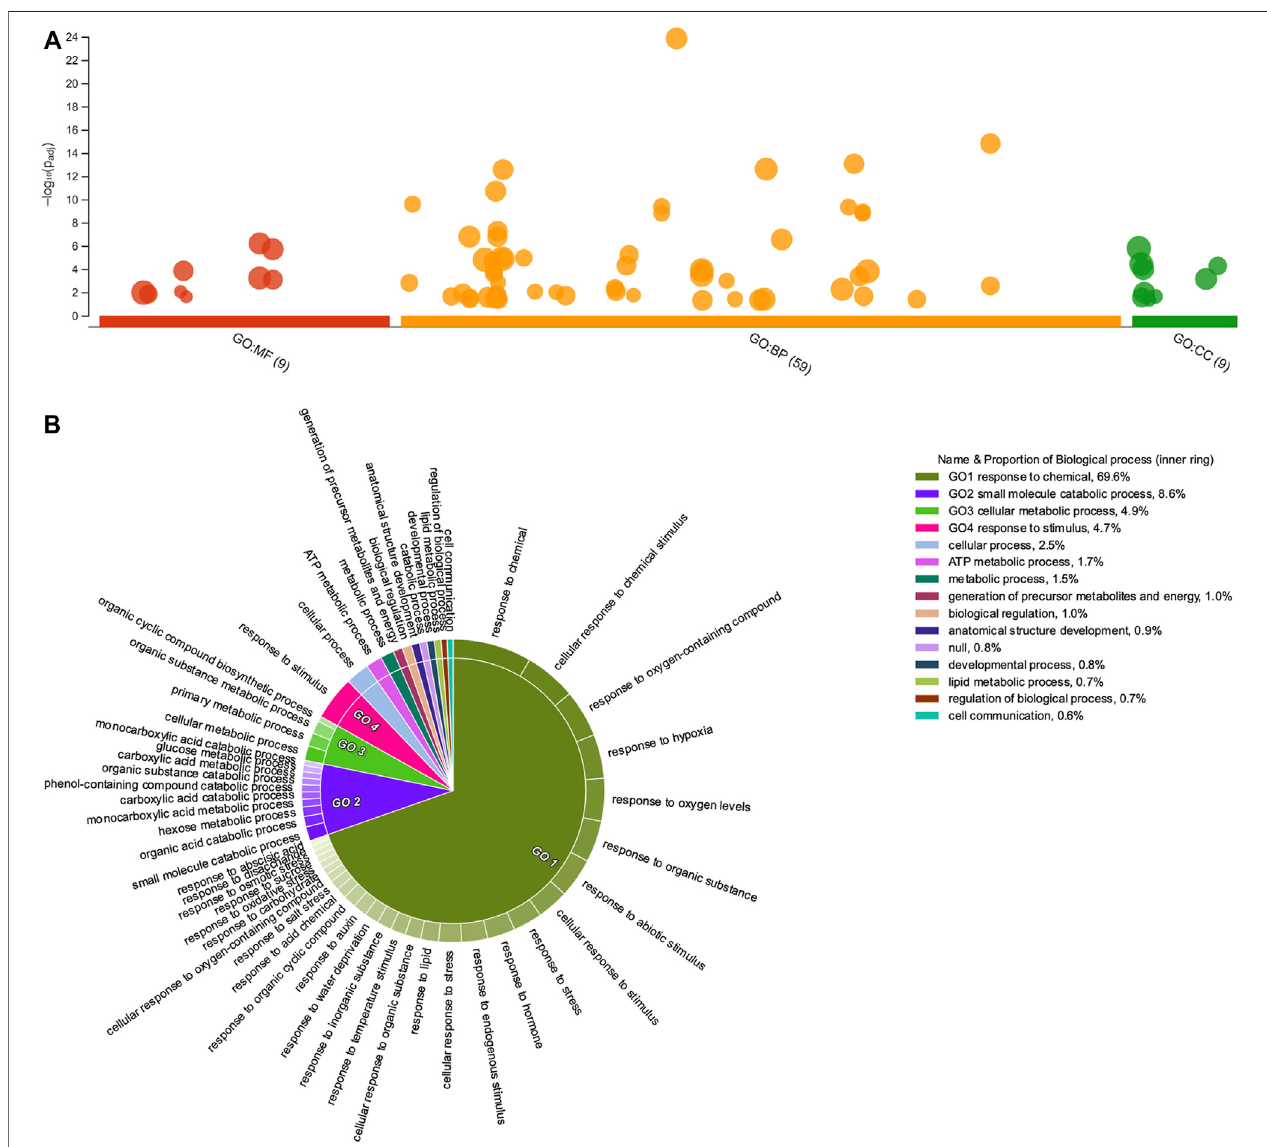
FIGURE 5 | Gene Ontology enrichment of downregulated Psittacanthus schiedeanus uniGenes involved in compound endosperm development after seed germination. (A) Manhattan plot illustrating the GO enrichment analysis results separated into the three major categories: MF (molecular functions), BP (biological processes), andCC (cellularcomponents).Thenumber inthesourcenameinthe x -axis labelsshowshow manyGOterms weresigni fi cantlyenriched (g:SCSthreshold, p -value ≤ 0.05). (B) BiologicalprocessesCirGOvisualizationplot.Intensityshadesofcoloredcategoriesre fl